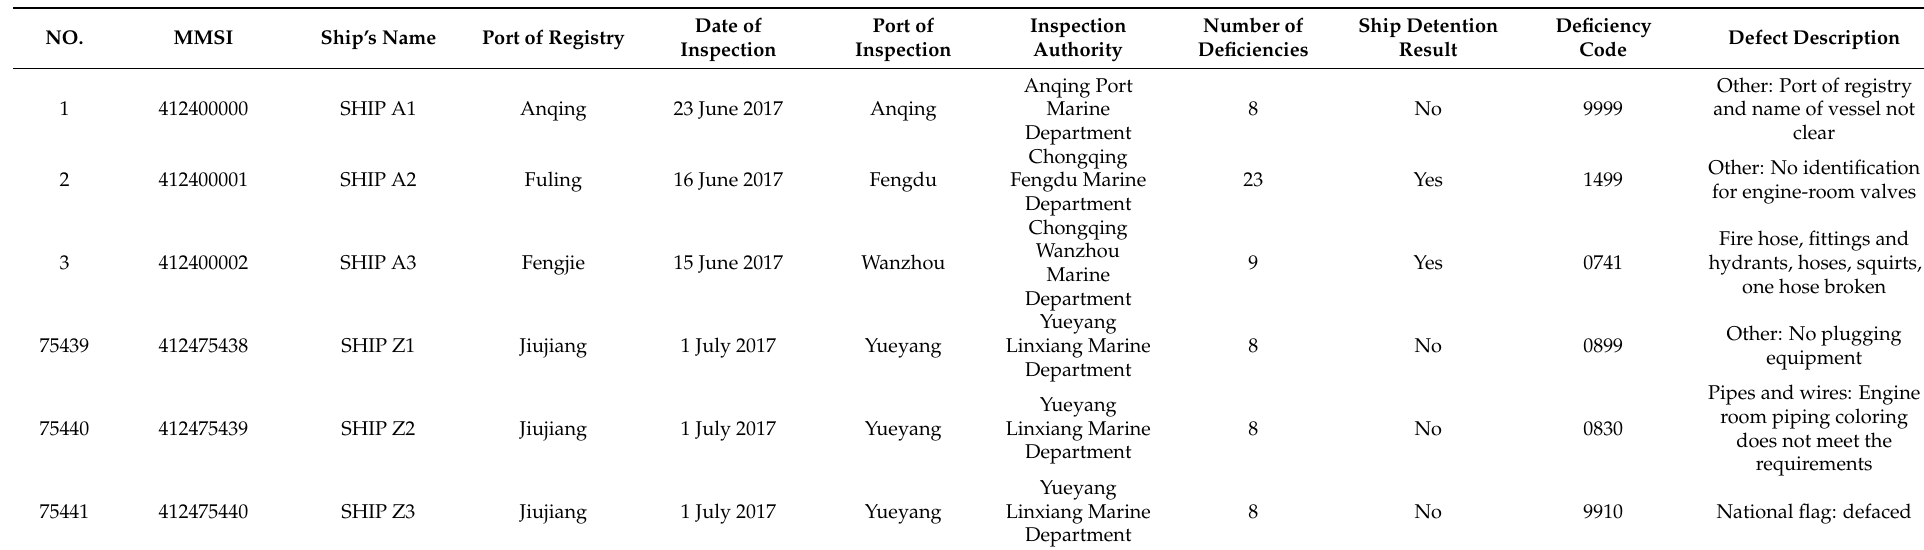
Table 1. Original flag state control (FSC) inspection